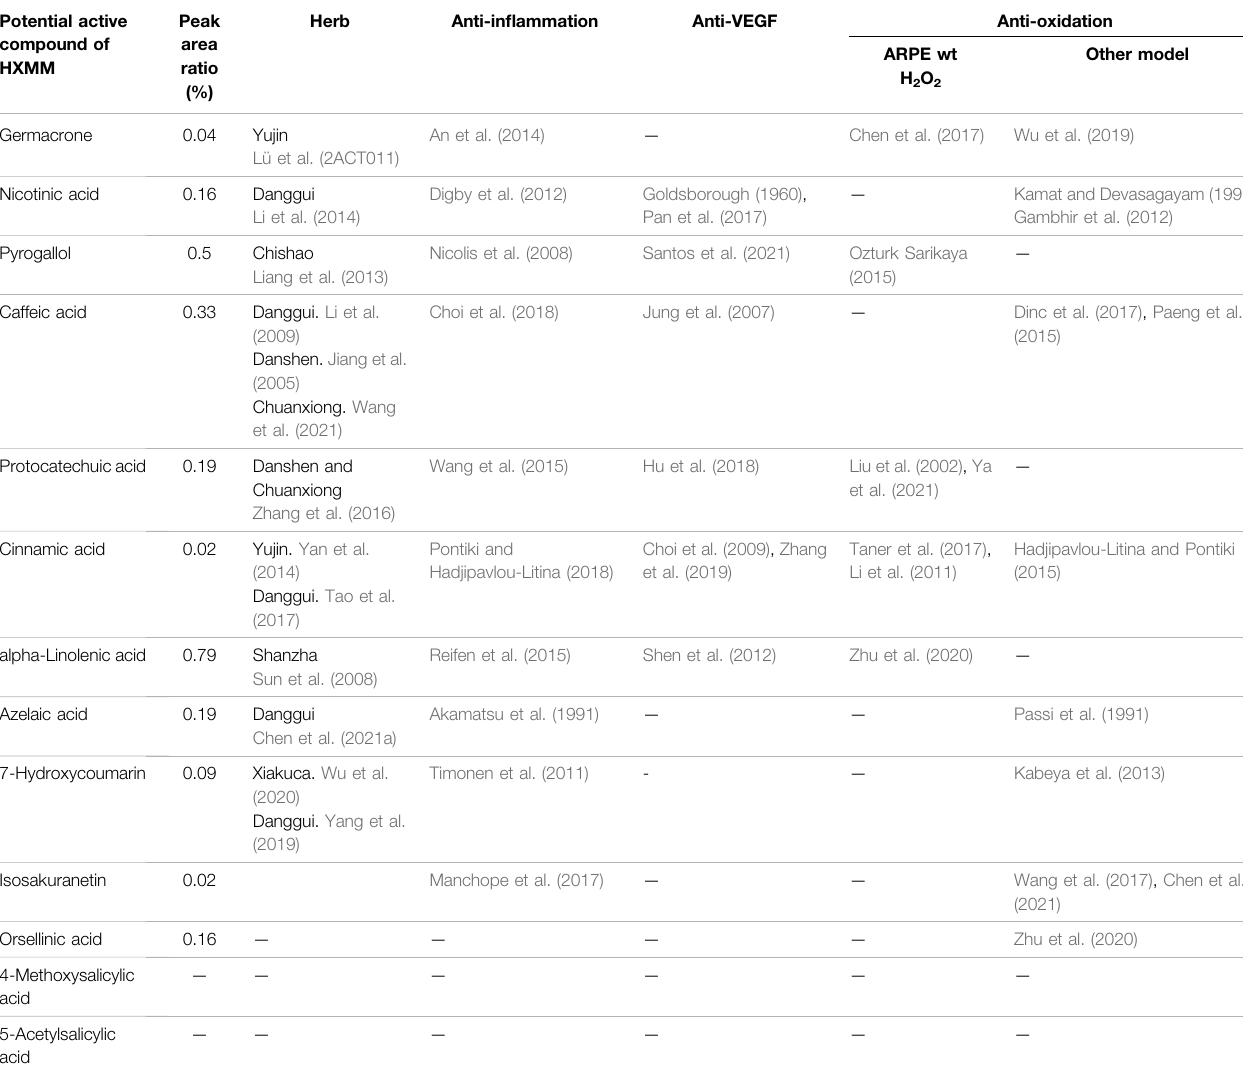
TABLE 1 | Potential Compounds of HXMM Tablet by